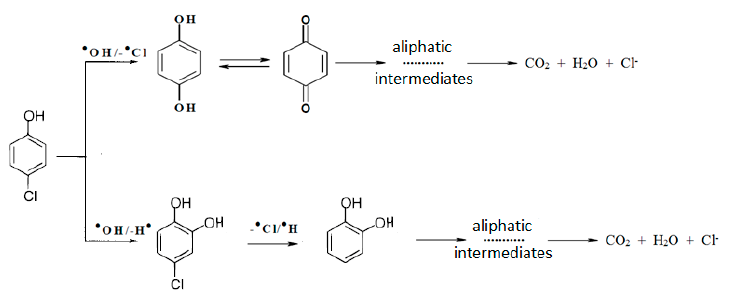
Figure 7. Speculative photocatalytic degradation pathways of 4-chlorophenol.